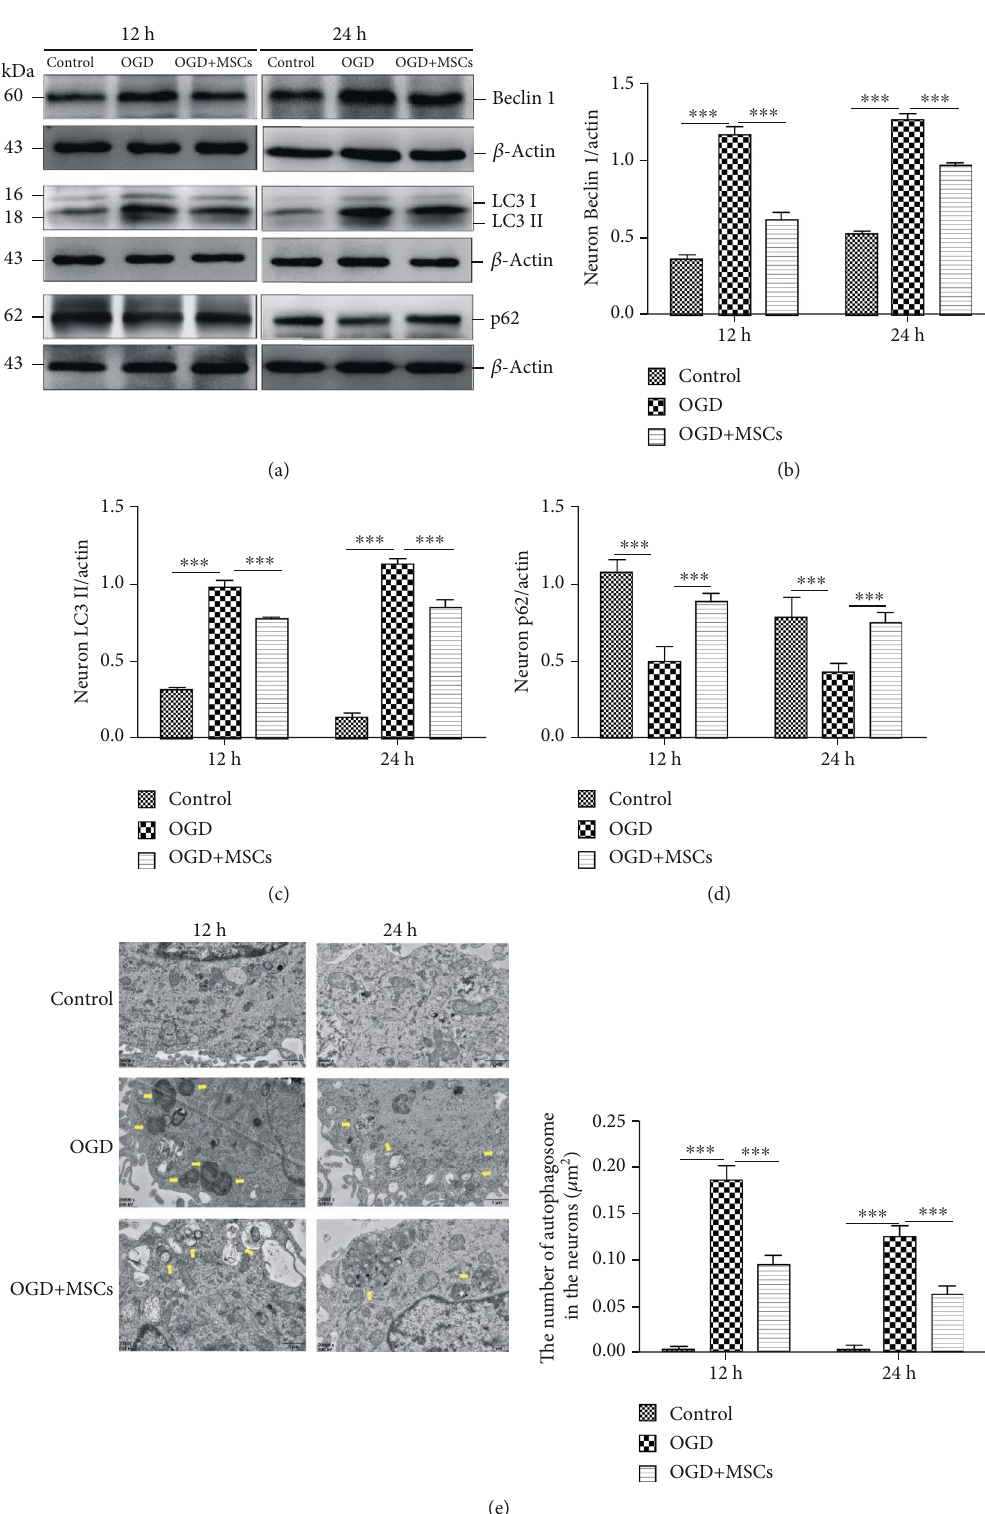
Figure 3: MSCs cocultured separately partly rescued the expression levels of the autophagy-associated proteins Beclin 1, LC3 II, and p62 and decreased the autophagosome numbers in primary hippocampal neurons with OGD injury. (a) Representative western blots of neuronal Beclin 1, LC3 II, and p62 protein expressions in the control, OGD, and OGD+MSC groups following injury for 12h and 24h. (b – d) Quanti fi cation analysis of the above protein expression levels normalized to β -actin in the primary neurons. (e) Number of autophagosomes in the neurons according to transmission electron microscopy (yellow arrows); quanti fi cation of the autophagosome numbers in the three groups. Scale bars = 2 μ m ( n = 6 , ∗∗∗ P < 0 : 001